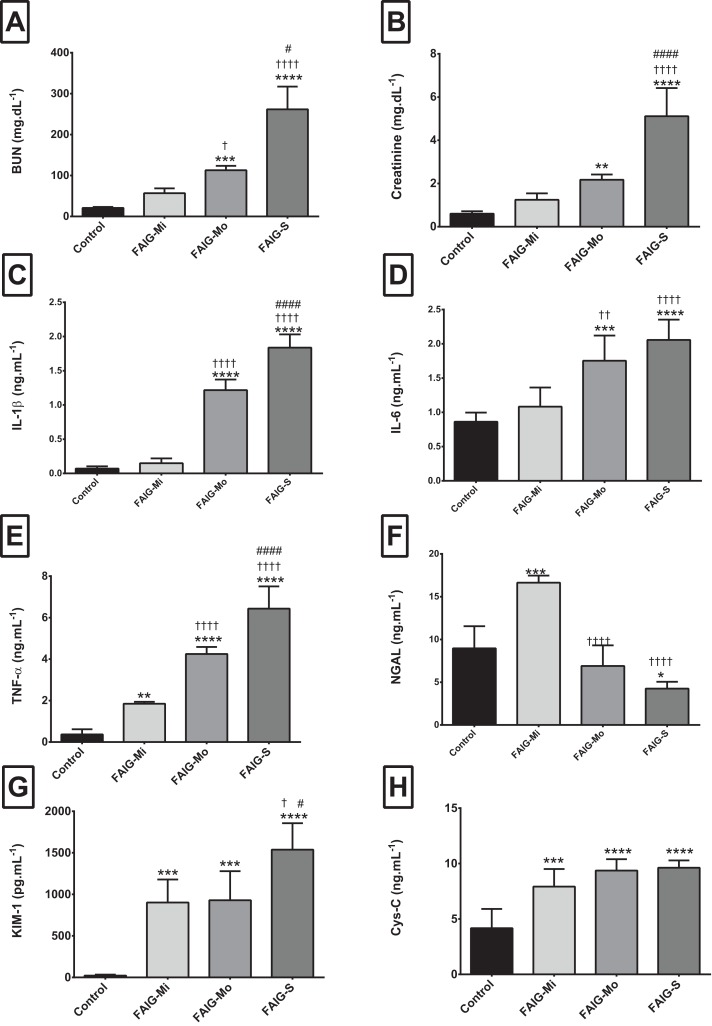
Serum levels of biochemical markers, pro-inflammatory cytokines and kidney injury biomarkers.(A) Serum level of BUN; (B) Serum level of creatinine; (C) Serum level of interleukin 1β; (D) Serum level of interleukin 6; (E) Serum level of tumor necrosis factor alpha; (F) Serum level of neutrophil gelatinase associated with lipocalin; (G) Serum level of kidney injury molecule-1; (H) Serum level of cystatin C. Values are expressed as means ± SD. N = 6 in each group. *P < 0.05 vs. C. †P < 0.05 vs. FAIG-Mi. #P < 0.05 vs. FAIG-Mo. FAIG-Mi: Mild damage, FAIG-Mo: Moderate damage, FAIG-S: Severe damage.